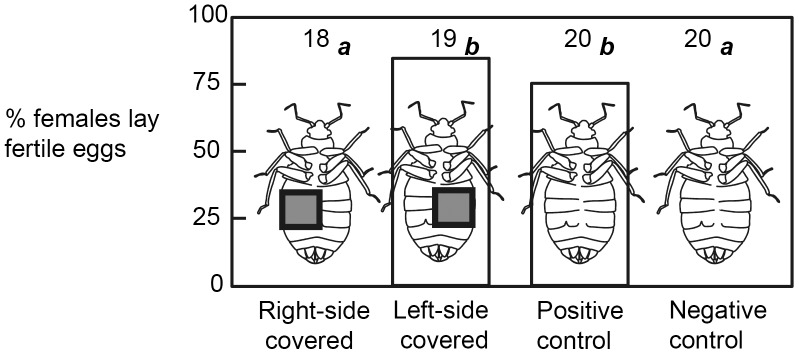
Proportion of female Cimex hemipterus that laid fertile eggs in the sealing experiment.The numbers above the columns indicate the sample sizes. A significant difference was detected between bars labeled with a and b (Fisher’s exact test, P<0.0001 after a sequential Bonferroni method), whereas bars labeled with the same letters were not significantly different (P>0.05).